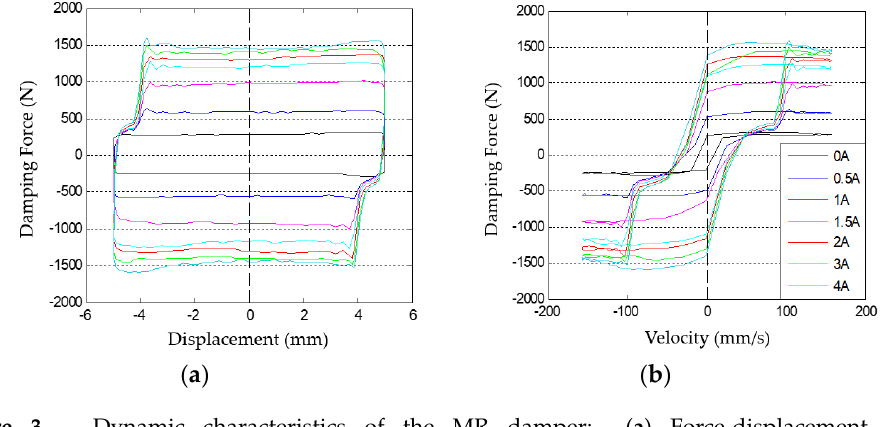
Figure 3. Dynamic characteristics of the MR damper: ( a ) Force-displacement curve; ( b ) Force-velocity curve